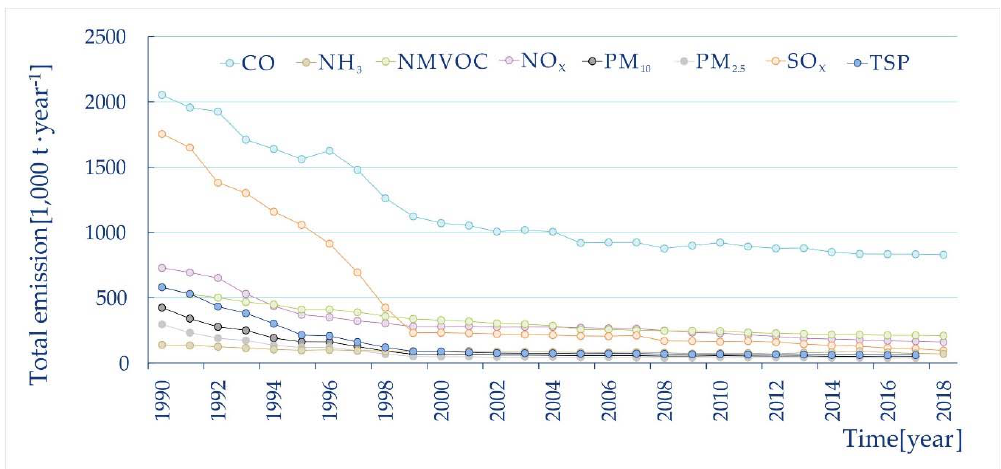
Figure 2. Total emissions of basic pollutants in the Czech Republic in the period 1990–2018. Results are based on emission inventories outcomes, regularly evaluated and published in air pollution reports in the Czech republic (e.g.,